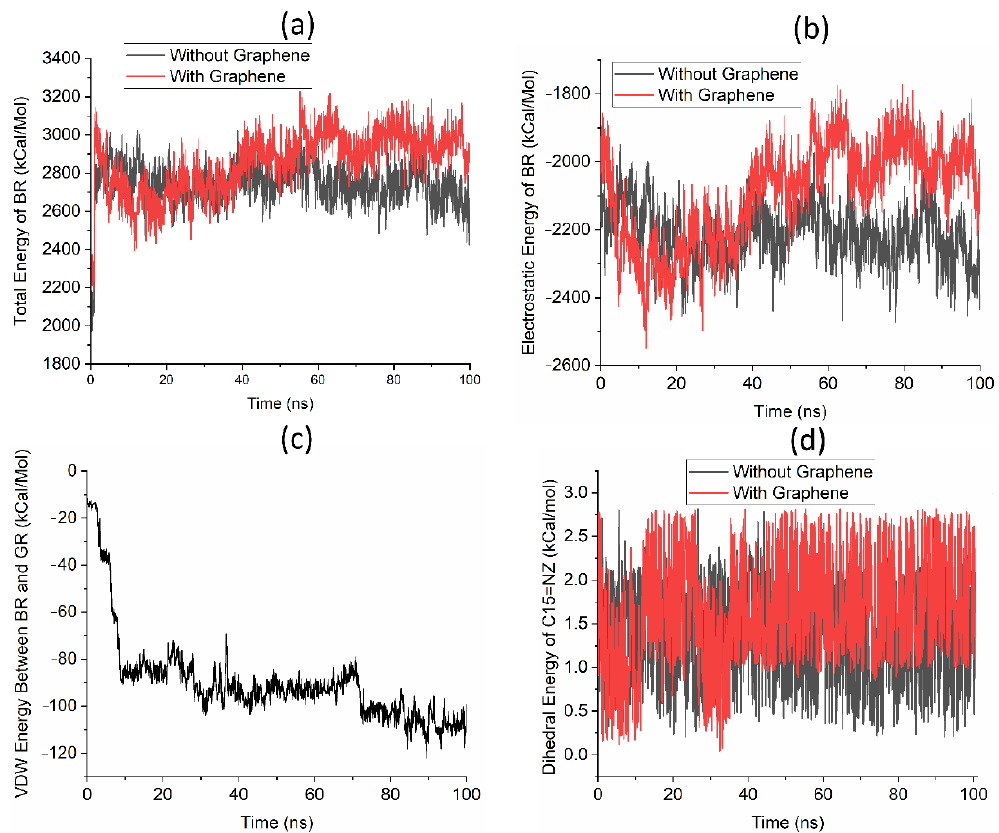
Figure 4. Analysis of different energies at the interface of bR and graphene: ( a ) Total energy within bR in the absence and presence of graphene; ( b ) Electrostatic energy of bR in the presence and absence of graphene; ( c ) Van der Waals energy at the interface of bR and graphene; ( d ) Dihedral energy of the key double bond between retinal and LYS216 of bR (C14-C15 = NZ-CE) in the presence and absence of graphene.